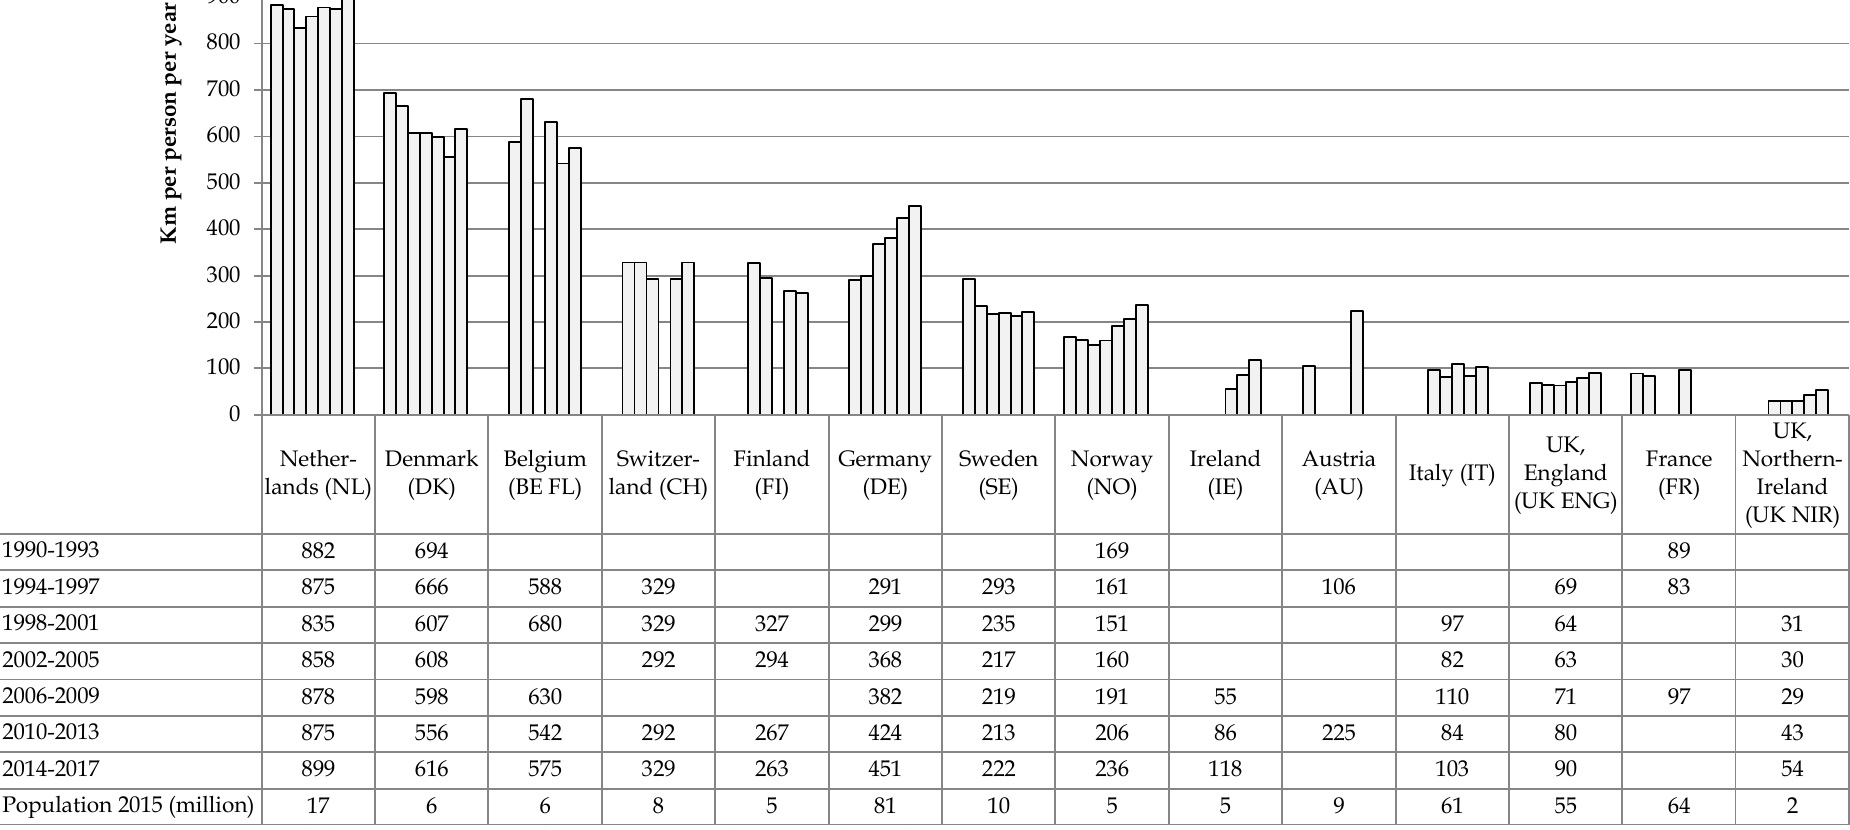
Figure 2. Distance cycled per capita per year between 1990 and 2017, and population size in